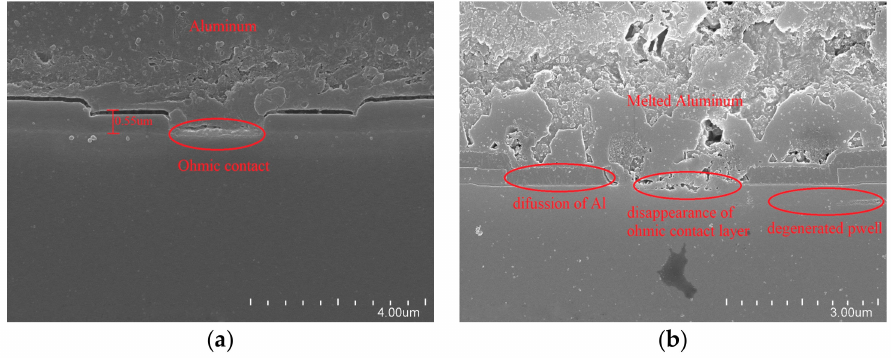
Figure 12. SEM images of SCT10N120 ( a ) before, ( b ) after the device failure.